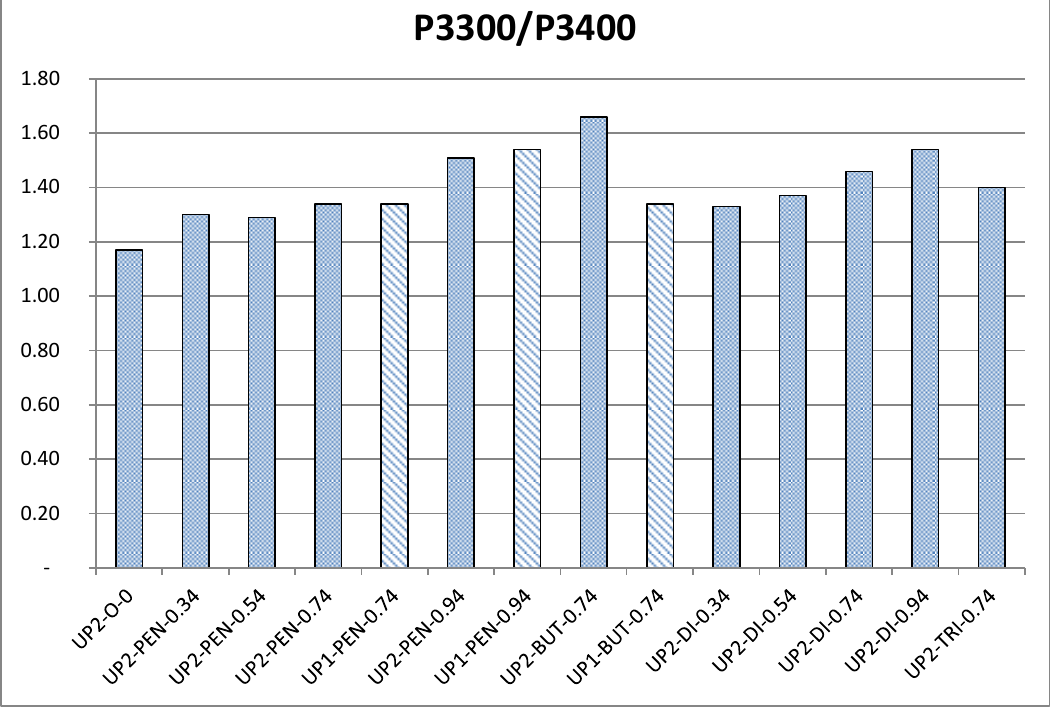
Figure 8. The intensity ratios of P3300 and P3400 of selected